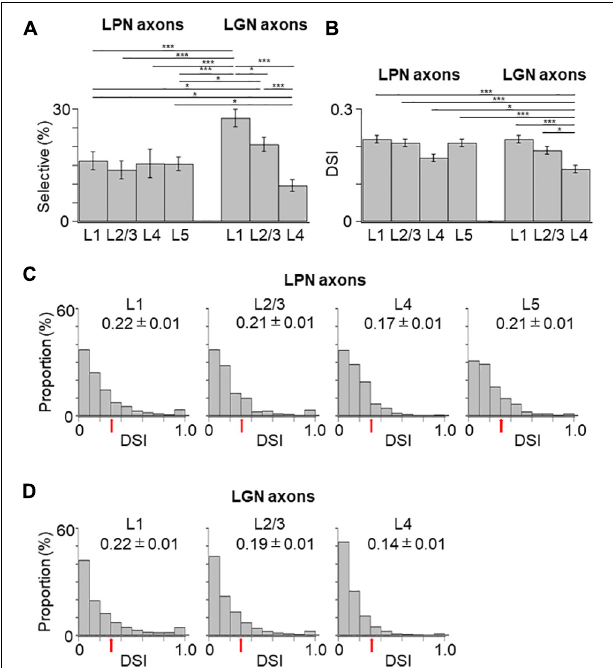
FIGURE 6 | Proportion of direction-selective boutons and distribution of DSI of the LPN and LGN boutons in V1. (A) The proportion of direction-selective LPN and LGN boutons. The proportion of the LGN boutons in layer 1 was significantly different from that of the LPN boutons in all the layers ( P ≤ 0.001, Mann–Whitney U -test with Bonferroni correction). The proportion of LGN boutons in layer 2/3 was significantly different from that of LPN boutons in layers 2/3 and 5 (layer 2/3, p = 0.032; layer 5, p = 0.045, Mann–Whitney U -test with Bonferroni correction). The proportion of LGN boutons in layer 4 was significantly different from that of LPN boutons in layers 1 and 5 (layer 1, p = 0.023; layer 5, p = 0.031, Mann–Whitney U -test with Bonferroni correction) and LGN boutons in the remaining layers ( p ≤ 0.001, Mann–Whitney U -test with Bonferroni correction). (B) The mean DSI of responsive LPN and LGN boutons. DSI of LGN boutons in the layer 4 was significantly lower than that of LGN boutons in the layer 1, LPN boutons in the layers 1, 2/3, 5 ( P ≤ 0.001, Mann–Whitney U -test with Bonferroni correction) and LGN boutons in the layer 2/3 and LPN boutons in the layer 4 (LGN layer 2/3, p = 0.015; LPN layer 4, p = 0.041, Mann–Whitney U -test with Bonferroni correction). DSI of LGN boutons between the layers 1 and 2/3 ( p = 1, Mann–Whitney U -test with Bonferroni correction) and DSI of LPN boutons among different layers were statistically not different (between layers 1 and 5, p = 0.882; other pairs, p = 1, Mann–Whitney U -test with Bonferroni correction). (C) The distribution of DSI of LPN boutons in the layer 1 (left, n = 187 boutons from six mice, 11 FOVs), layer 2/3 (second from left, n = 93 boutons from six mice, 7 FOVs), layer 4 (second from right, n = 81 boutons from five mice, 8 FOVs), and layer 5 (right, n = 134 boutons from two mice, 9 FOVs). (D) The distribution of DSI of LGN boutons in the layer 1 (left, n = 1,954 boutons from 37 mice, 123 FOVs), layer 2/3 (middle, n = 1,630 boutons from 36 mice, 97 FOVs), and layer 4 (right, n = 931 boutons from 30 mice, 98 FOVs). Arrows show the threshold (DSI = 0.3) for direction-selective boutons. DSI, direction-selective index; LPN, lateral posterior nucleus; LGN, lateral geniculate nucleus; V1, primary visual cortex; FOV, field-of-view. * P ≤ 0.05; *** P ≤ 0.001. The data of LGN axons are re-use from the previous publication (Kondo and Ohki, 2016).